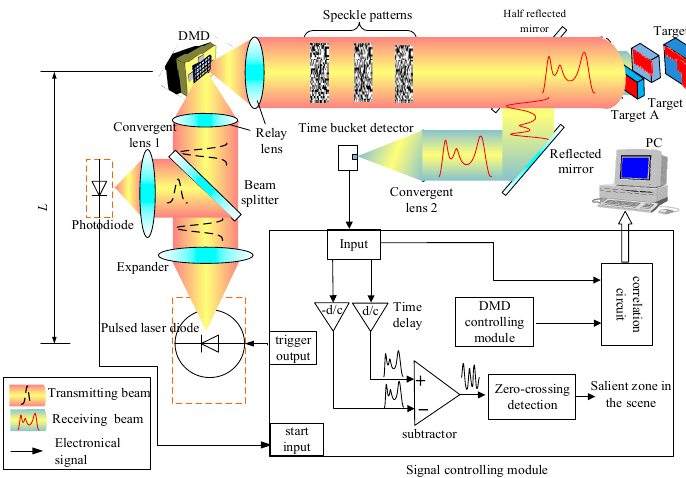
Figure 2. Principle of 3D ghost imaging (GI) based on non-uniform time-slice method (NUTSM) combined with finite difference .